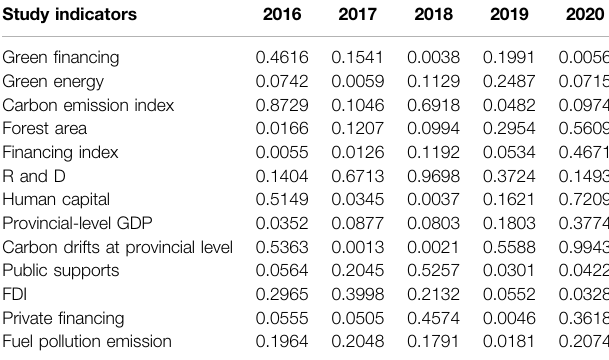
TABLE 4 | Dynamics of study variables over the sample period in Chinese